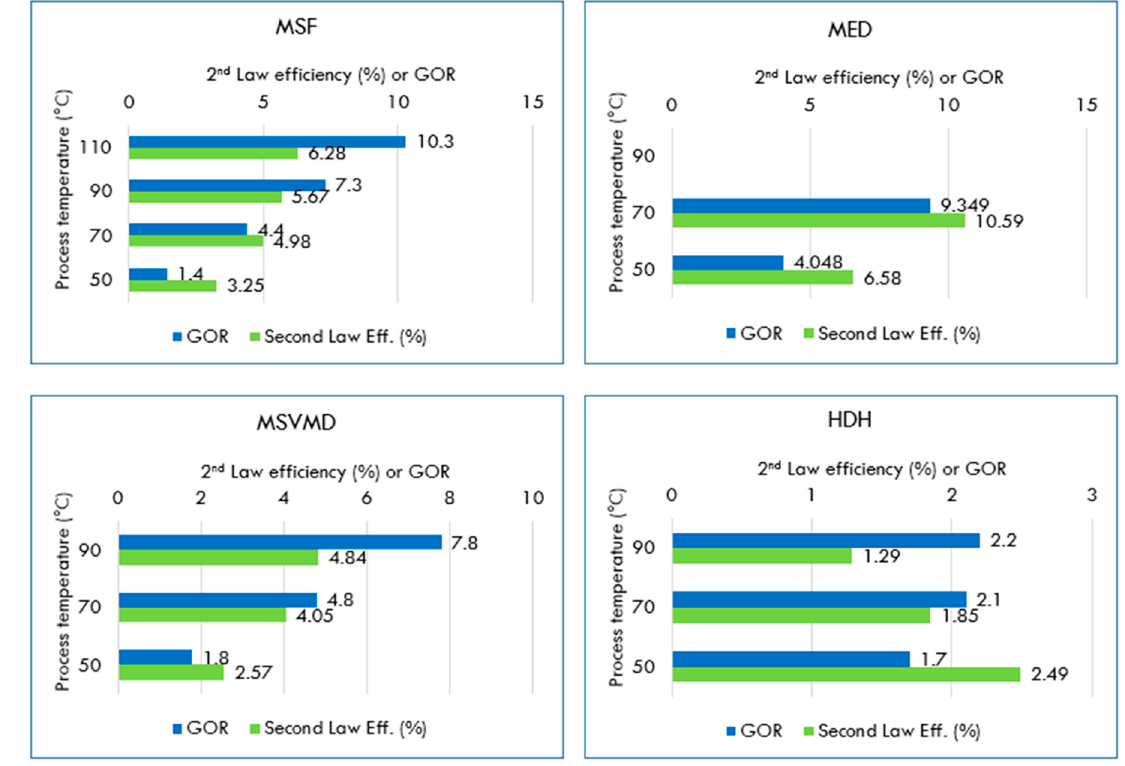
Figure 15. ( a ) Exergy balance of the solar powered MD unit with a heat exchanger; ( b ) exergy destruction in individual components.